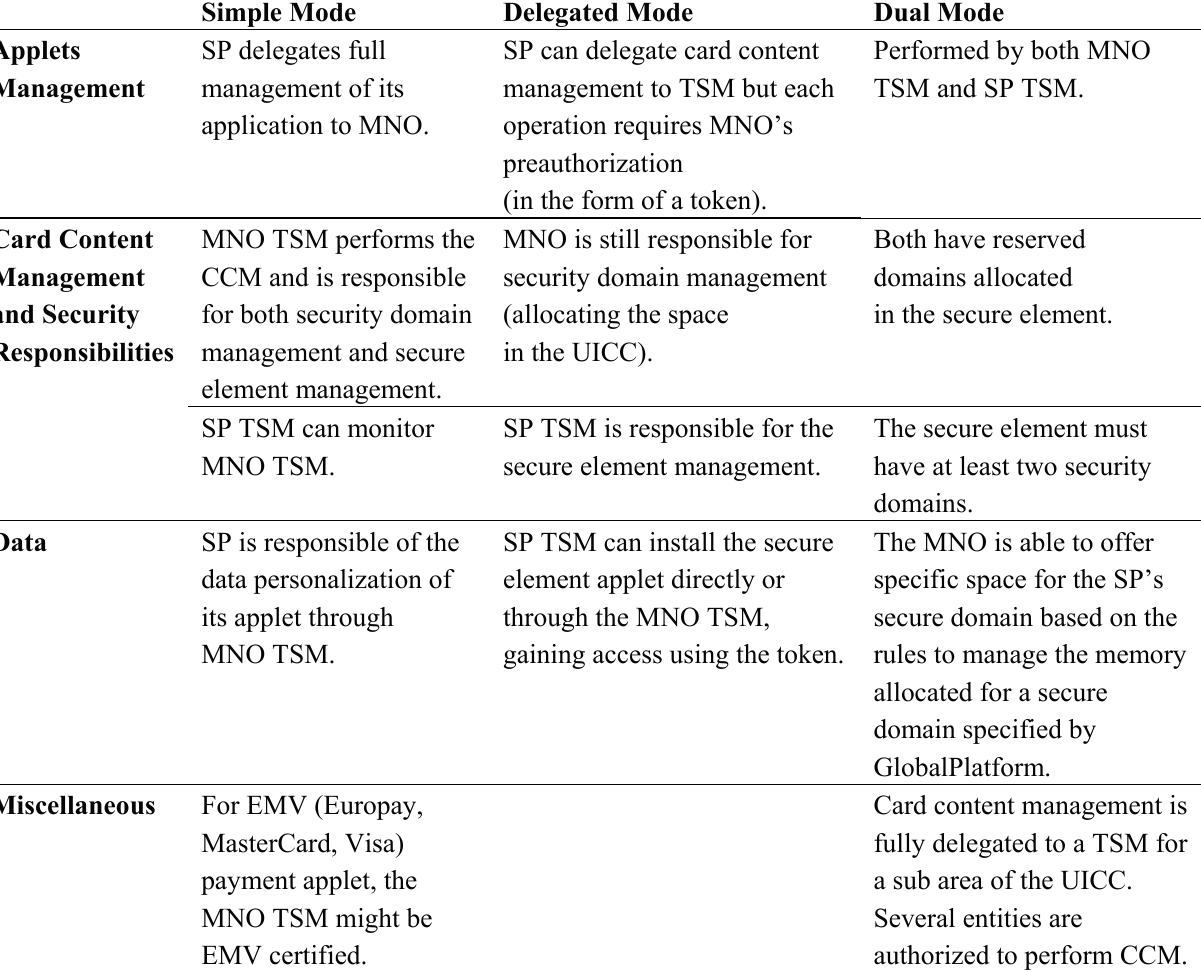
Table 3. Three management modes of service provider applets (source: authors’ elaboration based on